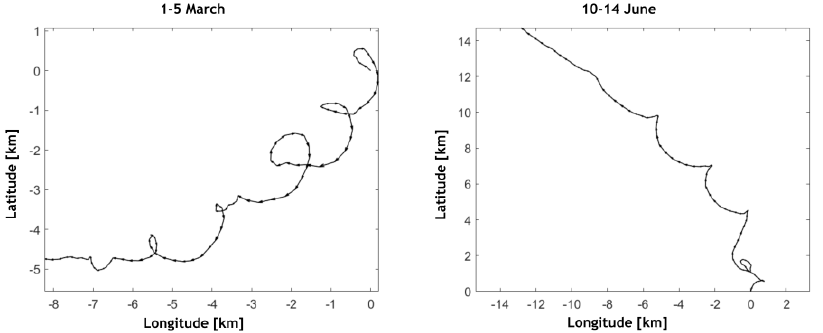
Figure 11. Progressive vector diagrams of currents at 100 m depth for selected periods in March ( left ) and June ( right ) of 2017.